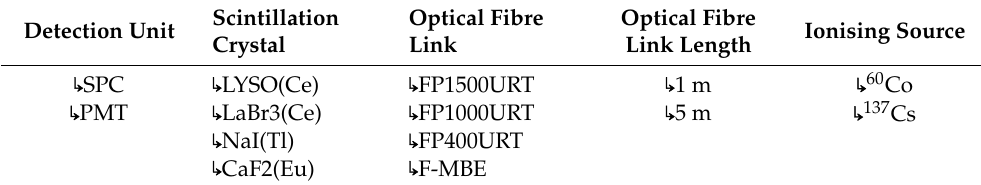
Table 1. Combination of all measurement options.